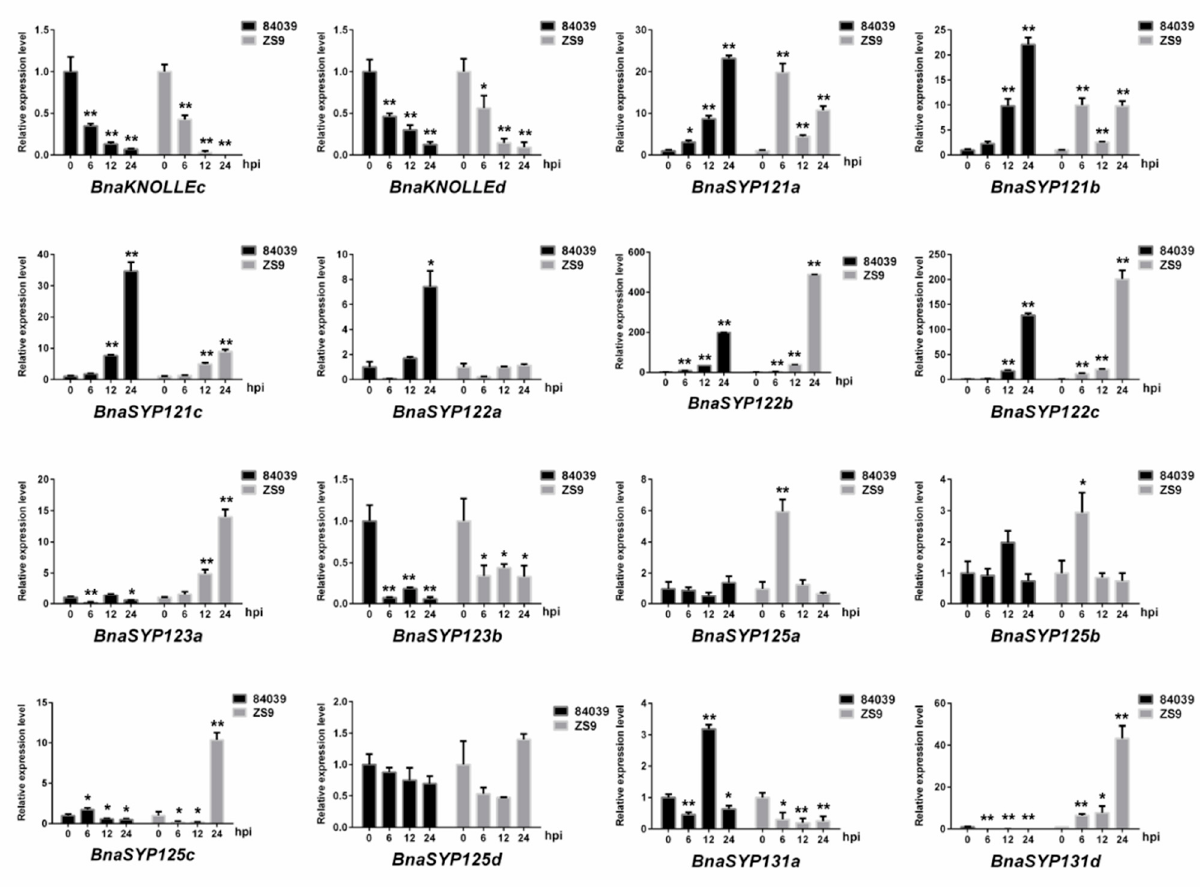
Figure 6. Expression of BnaSYP1-type genes in resistant variety Zhongshuang9 and susceptible variety 84039 of B. napus at different times after inoculation with S. sclerotiorum . RT-qPCR data were calculated by the methods of 2 −ΔΔ CT . STDEV is indicated as error bars. All data are the mean of 3 biological replicates. Significant differences are shown by * ( p < 0.05) and ** ( p < 0.01).